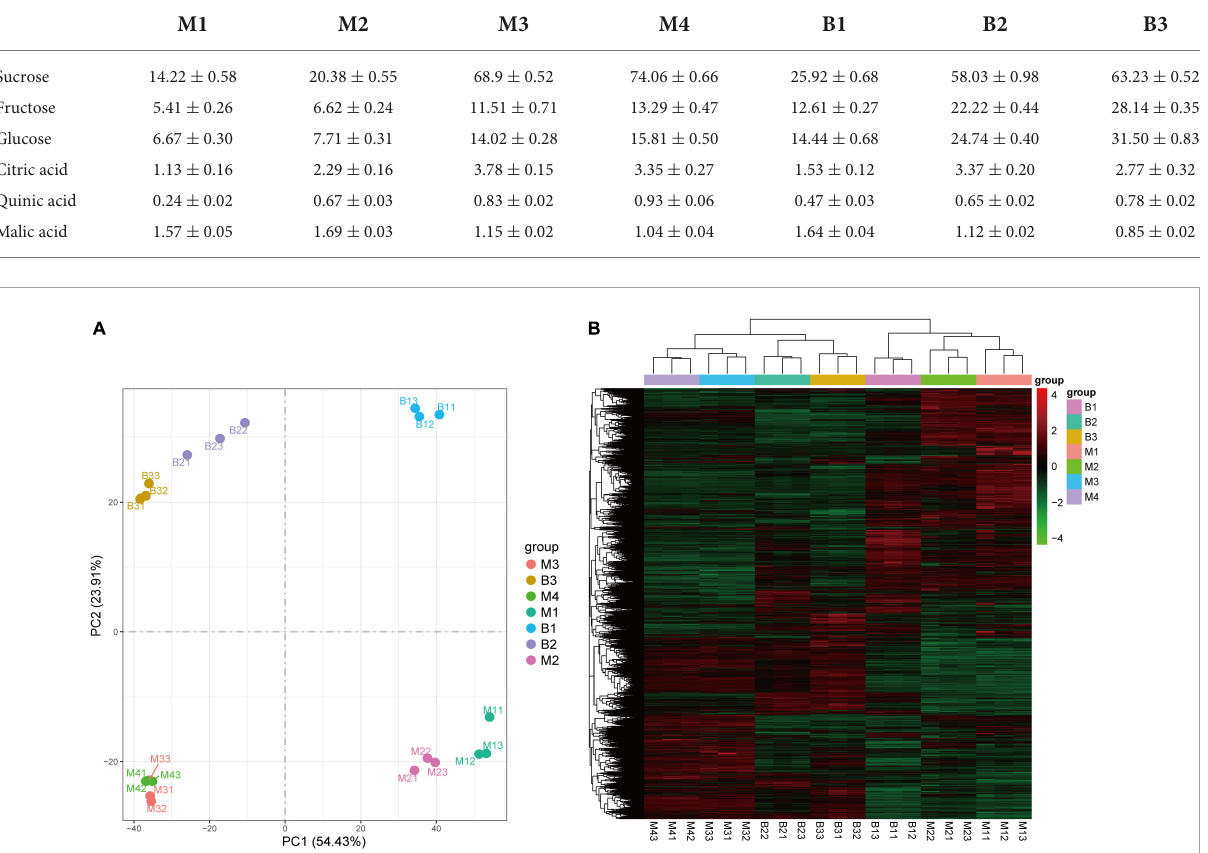
TABLE 3 Content of sugars and organic acids at different developmental stages in M and B cultivar (mg · g − 1 FW) and the values shown are the mean ± SD.